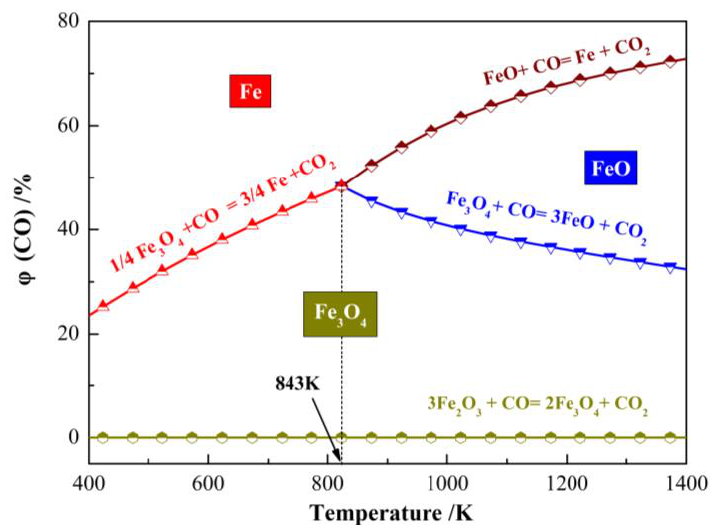
Figure 4. Diagram of equilibrium phase composition of iron oxide reduction reaction.